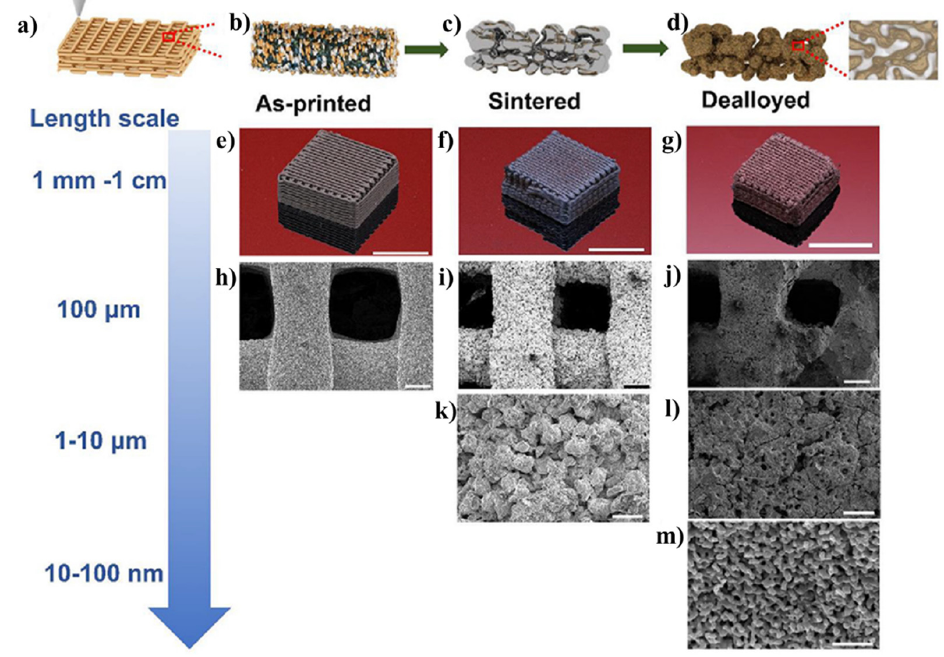
Figure 4. The fabrication of nanoporous materials of tunable porosity by 3D printing and chemical dealloying: ( a , b ) Digitally controlled macroporous 3D structures made from mixed Cu and Mn powder and polymer binder by direct ink writing; ( c ) thermal sintering at high temperature (1293 K) for 15 h to remove polymers and form Cu-Mn alloy; ( d ) nanoporous Cu fabrication by chemical dealloying in acidic environment to selectively remove Mn; ( e – g ) optical images of as-printed sintered and dealloyed sample. The scale bar in images ( e – g ): 10 mm. SEM images showing pore evolution after ( h ) 3D printing; ( I , k ) thermal sintering; and ( j – m ) dealloying. The scale bar in ( h – j ) and ( k – l ) are 100 µm and 20 µm. The scale bar in (m) is 400 nm. Adapted from [120], Copyright 2020, Elsevier.